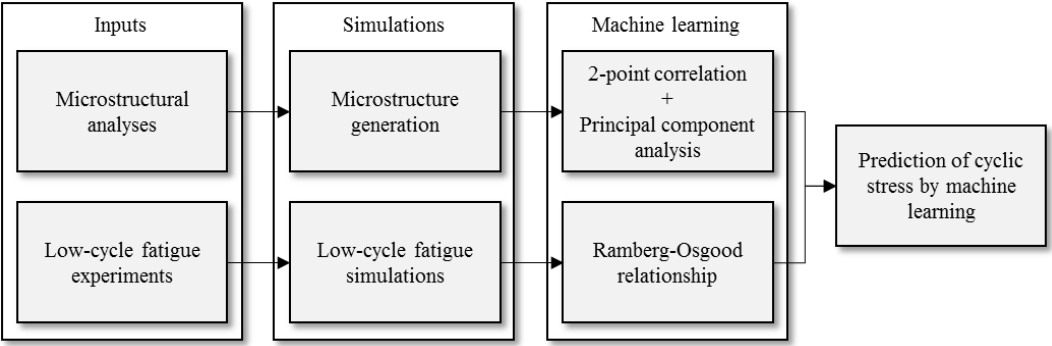
Figure 1. Framework to predict cyclic stress–strain property from microstructure by combining finite element simulation, two-point correlation, and machine learning.